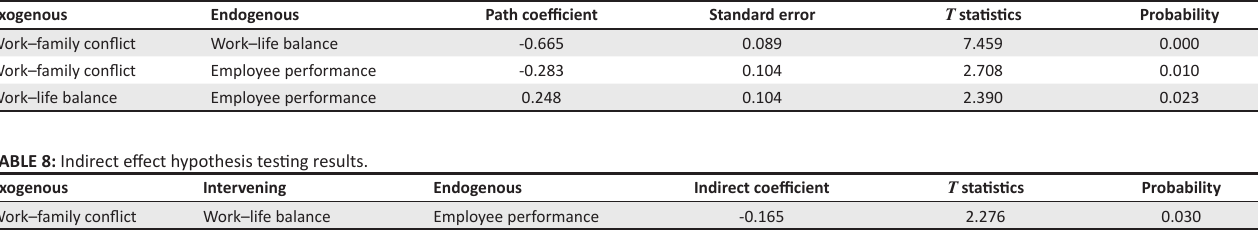
TABLE 7: Hypothesis testing